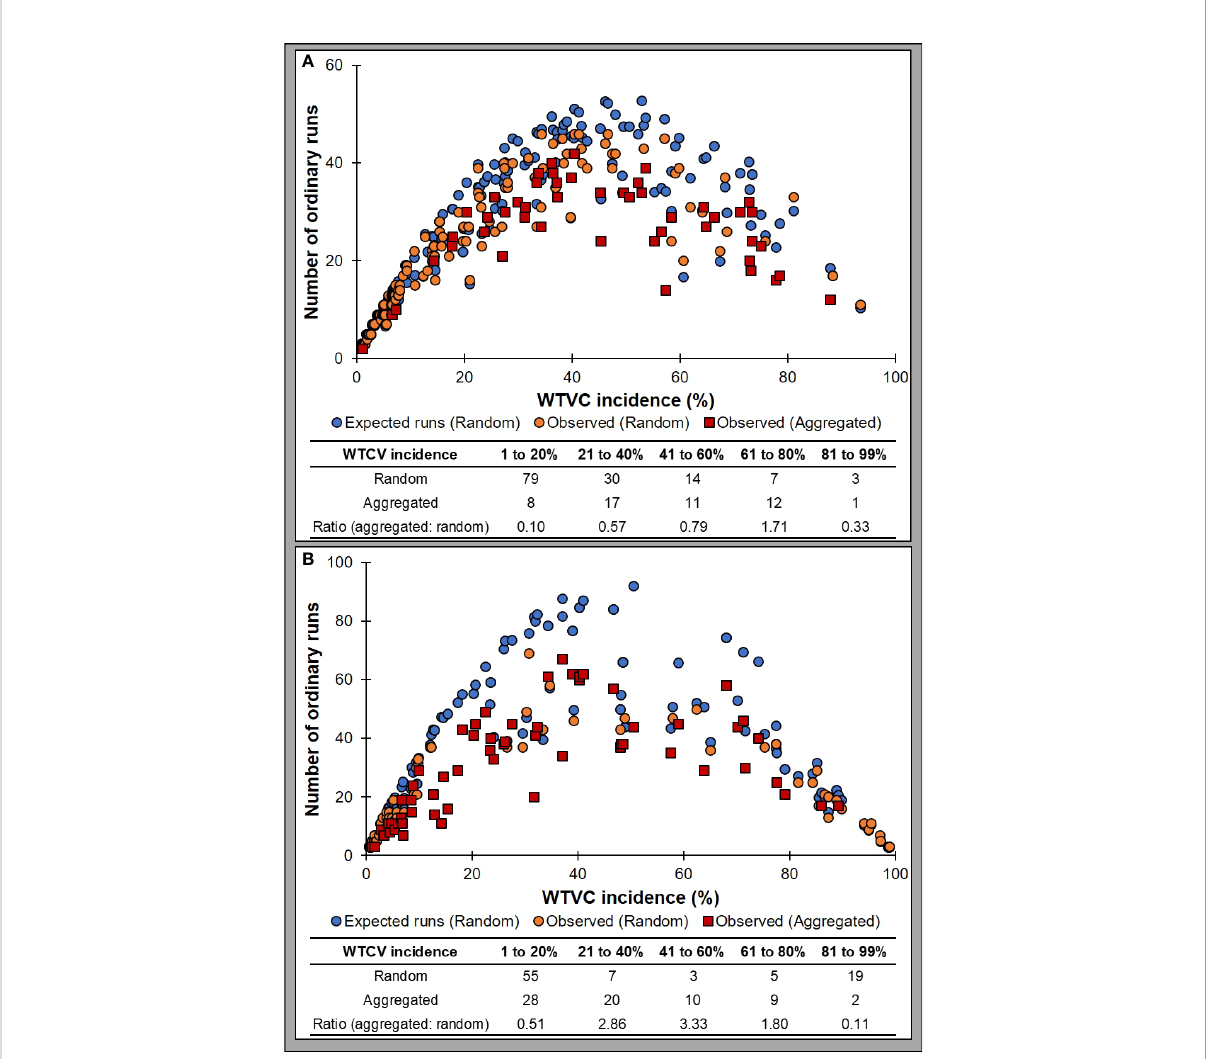
FIGURE 5 Analysis of one-dimensional spatial distribution of WTVC per row of plants based on ordinary runs analysis in experimental (A) and commercial (B) squash fi elds. The graph for the experimental fi eld (A) comprised data collected in fi eld trials conducted in 2019 and 2020 fall growing seasons. The plot of commercial fi elds (B) includes data collected from all six commercial squash fi elds that were surveyed in 2019 and